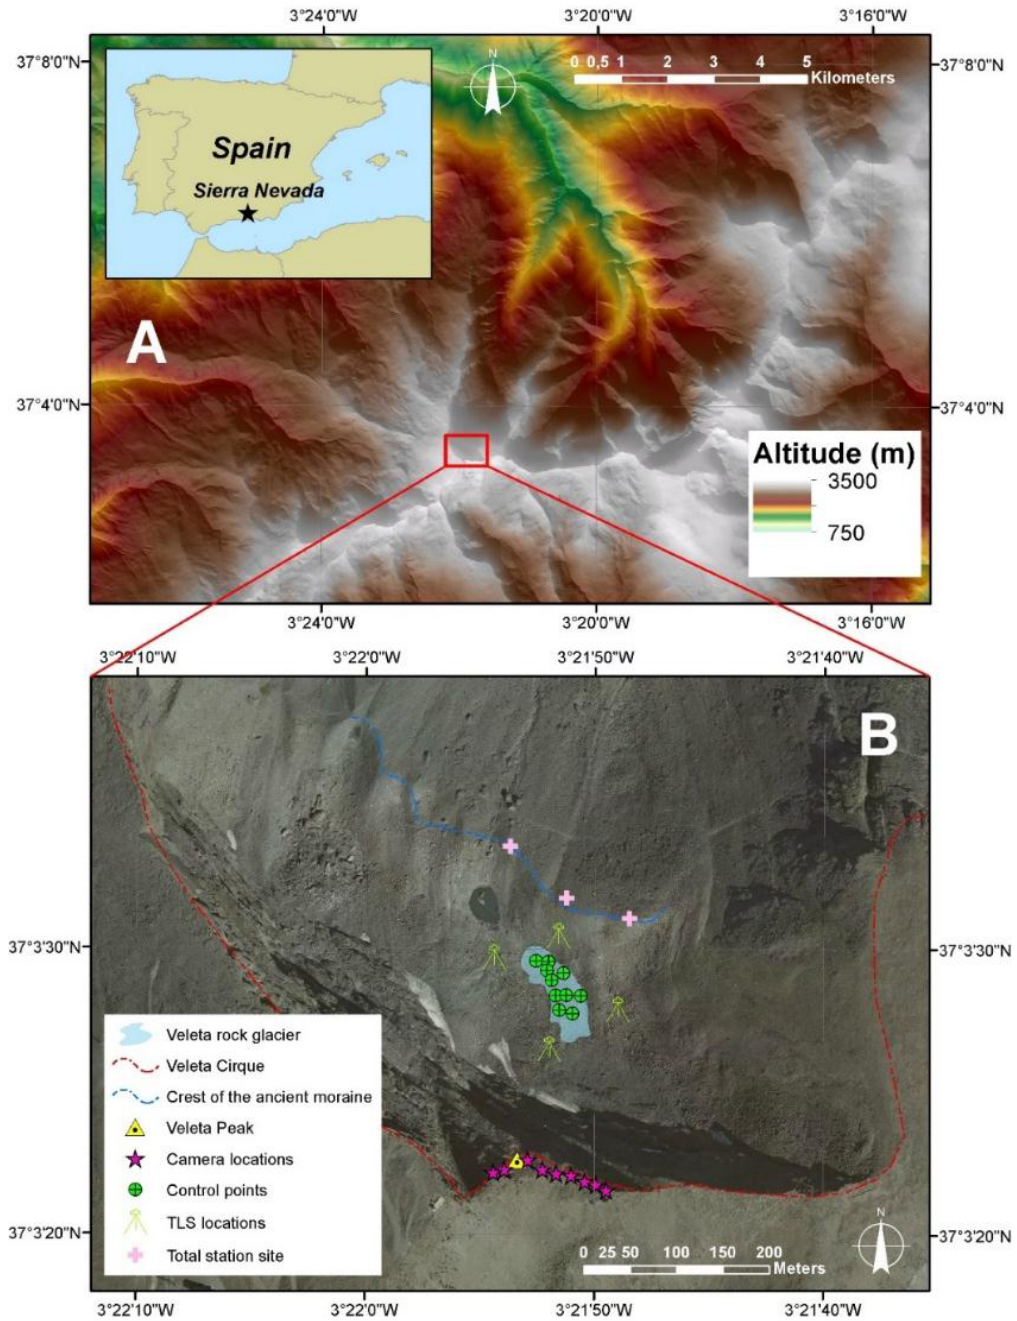
Figure 1. ( A ) Location of the study area in the Iberian Peninsula and ( B ) Orthophotograph of the study area that includes the extension of the Corral del Veleta rock glacier, the crest of the ancient lateral moraine, the border of the Veleta Cirque and the Veleta Peak (3398 m.a.s.l.). Additionally, camera locations, control points, Terrestrial Laser Scanner (TLS) and total station sites are shown in